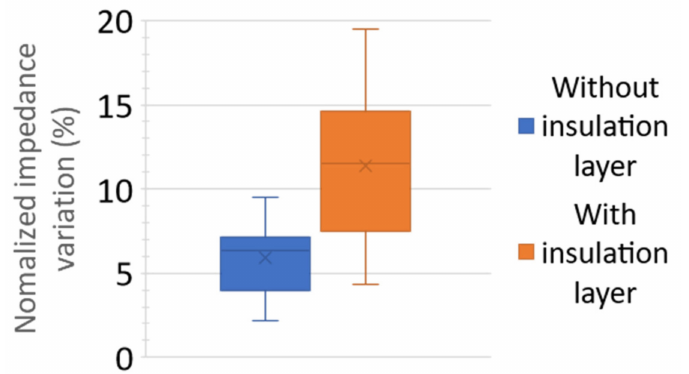
Figure 9. Statistical distribution of the experimental normalized impedance variation for the biosensors, BS1 and